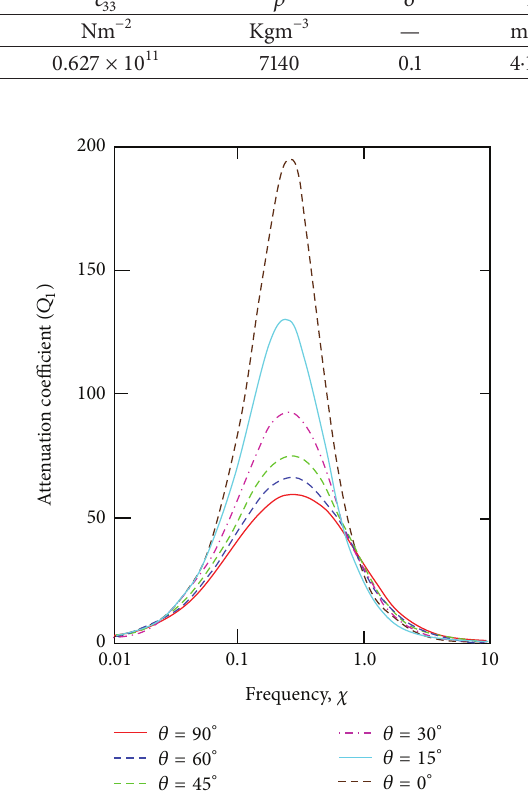
Figure 1: Variation of QL wave velocity with nondimensional frequency in various direction of propagation.